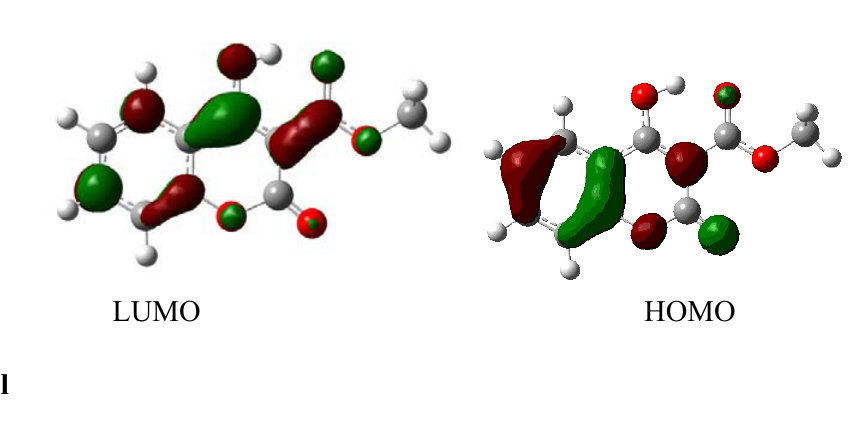
Figure 8. HOMO ( − 0.25988eV) and LUMO ( − 0.09171eV) orbitals of 3-methoxycarbonyl- 4-hydroxy coumarin after single point PCM